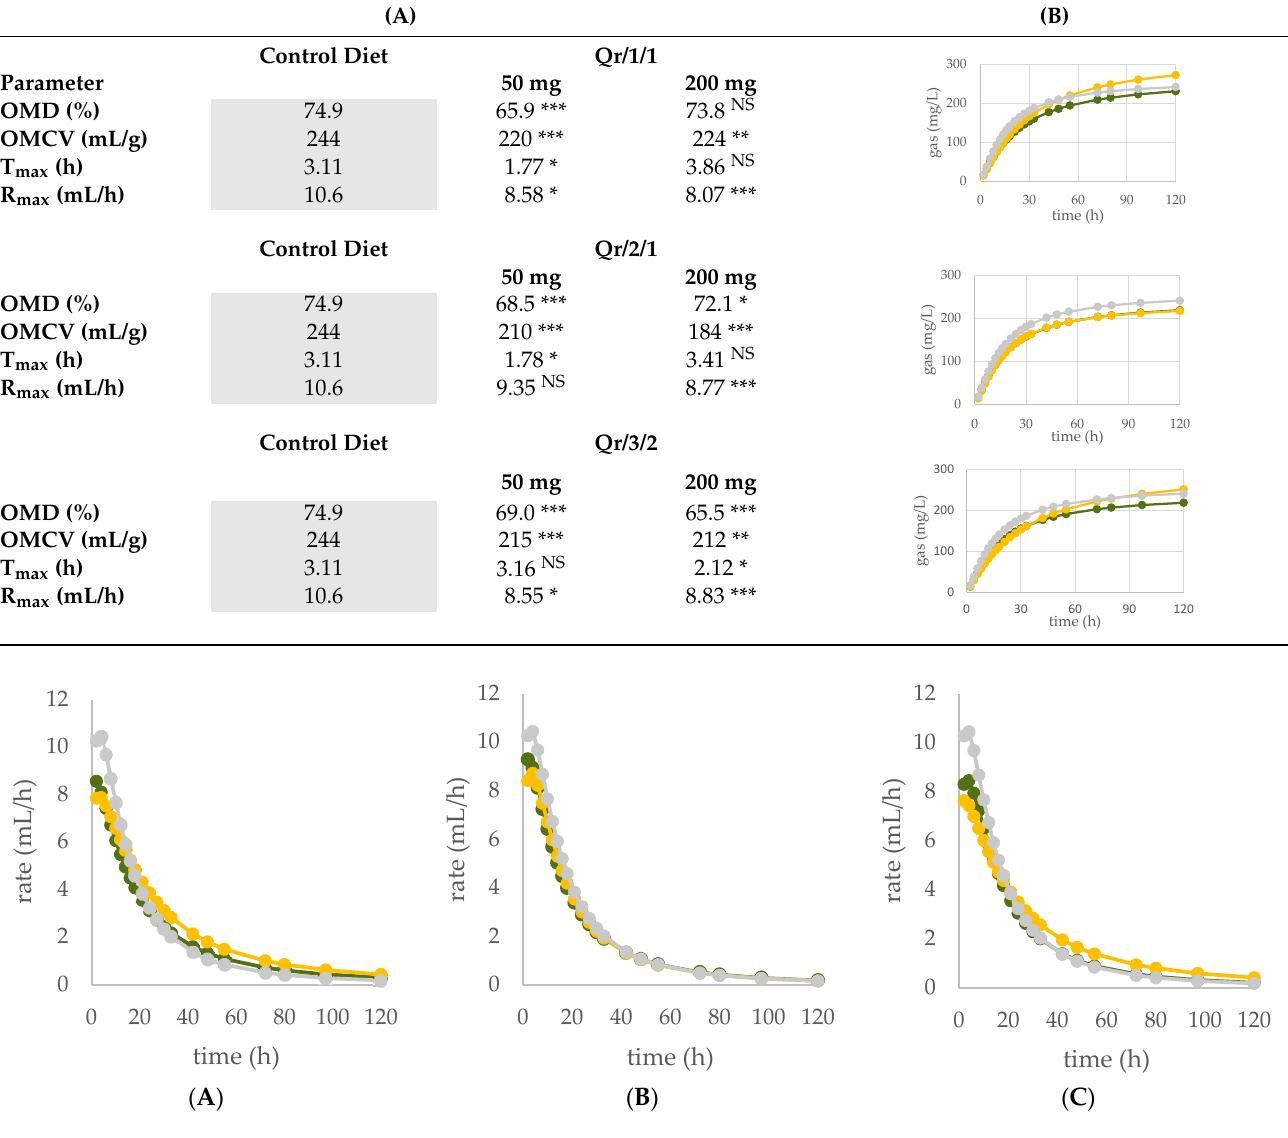
Figure 8. In vitro fermentation rate over time of Q. robur Qr/1/1 extract ( A ) and its fractions Qr/2/1 ( B ) and Qr/3/2 ( C ) at the 50-mg ( ● ) and 200-mg ( ● ) dose levels and control diet ( ● ).